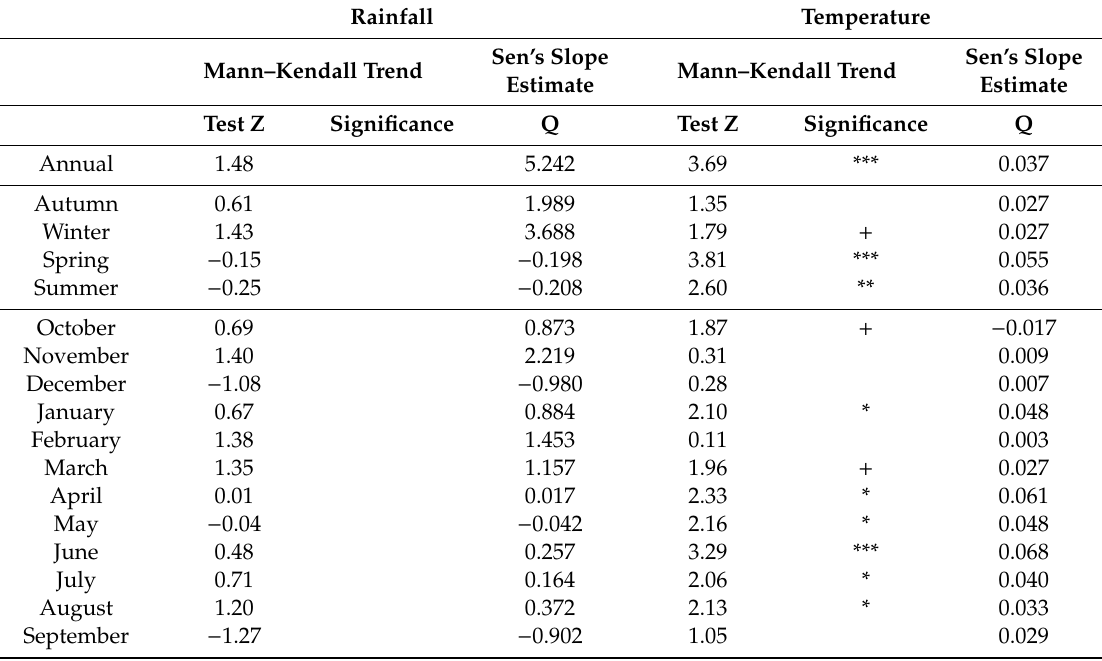
Table 1. Statistics (Z of the Mann–Kendall Test and Q of the Sen’s Slope Estimator) for rainfall and temperature trend